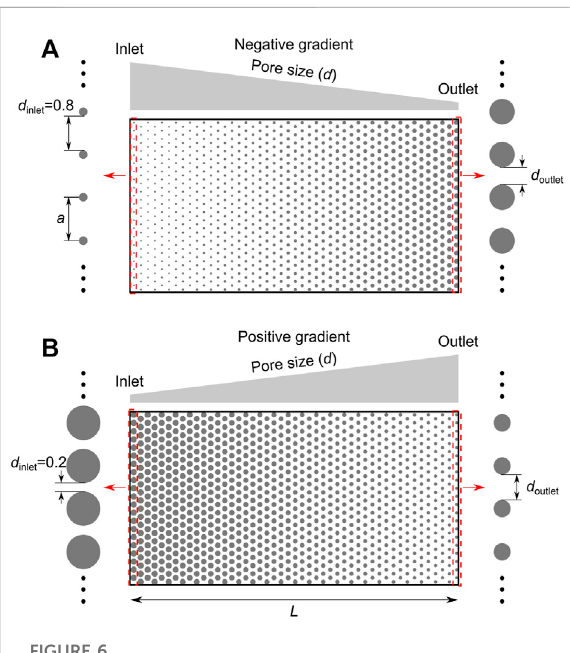
FIGURE 6 Geometry for the ordered porous media. (A) For negative gradient porous media, the pore size remains constant at the inlet, with d inlet = 0.8. (B) For positive gradient porous media, the pore size is d inlet = 0.2 at the inlet. The gradient is calculated by λ = ( d outlet - d inlet ) a / L . Here, d outlet is the pore size in the outlet, and L is the length of the porous